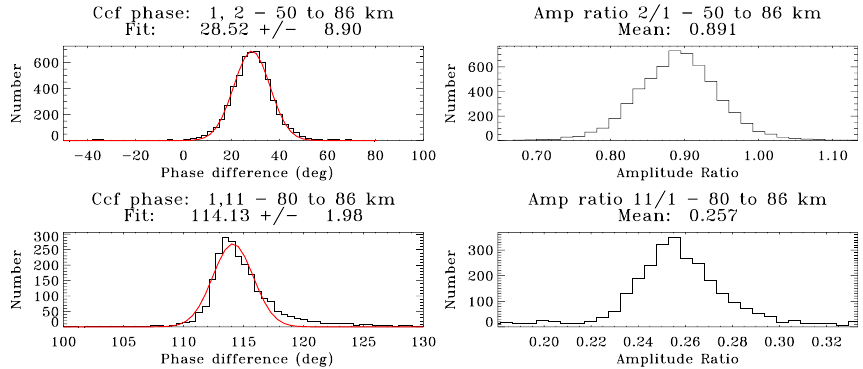
Fig. 5. Examples of histograms of phase differences (left) and amplitude ratios (right) obtained by applying the RCC to daytime data from between 4 and 9 April 2000. The red lines on the phase differences plots show the result of applying a Gaussian fit.